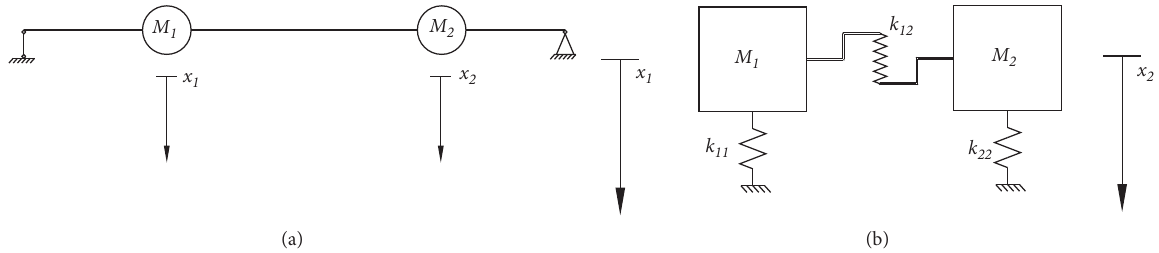
Figure 3: The simplified model of interaction between beam portions. (a) Two adjacent lumped mass blocks simplified from a single beam. (b) Interaction from two adjacent beam portions.